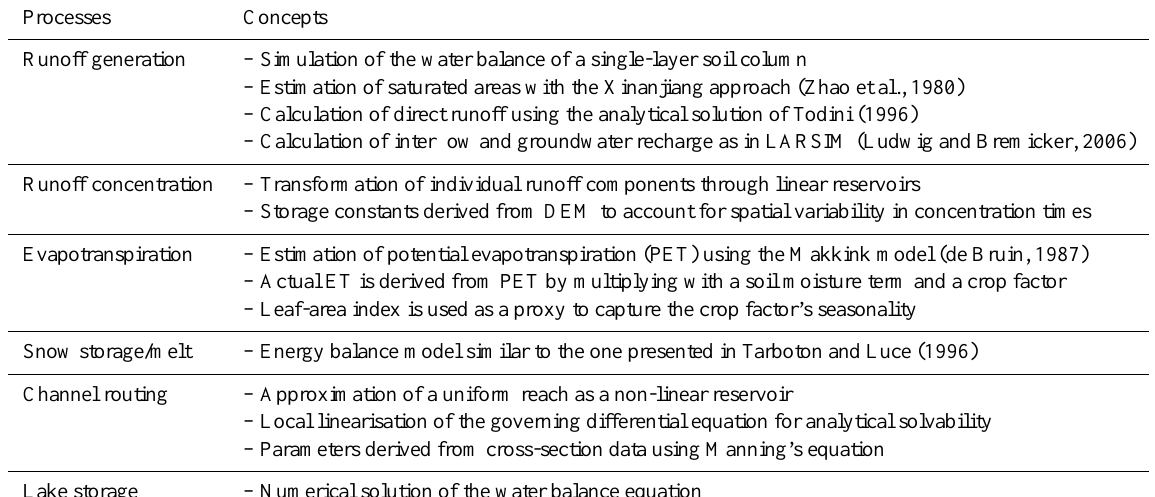
Table 4. Concepts used by HYPSO-RR to simulate major hydrological processes at the level of sub-basins, river reaches, or lakes. Processes